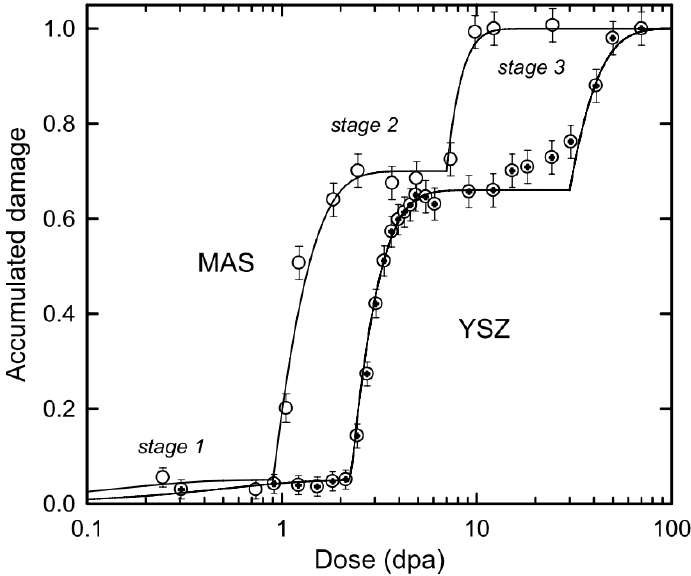
Figure 9. Accumulated damage ( f d ) in YSZ and MAS crystals irradiated at RT with low-energy (160 keV) Cs ions. Solid lines are fits to RBS/C data using the MSDA model with m = 3 (three-step process). The conversion factors of fluence (expressed in 10 15 cm −2 ) to dpa scales are: 2.45 for MAS and 3.46 for YSZ crystals. Reproduced with permission from Reference [185], Copyright © Springer Nature 2009.